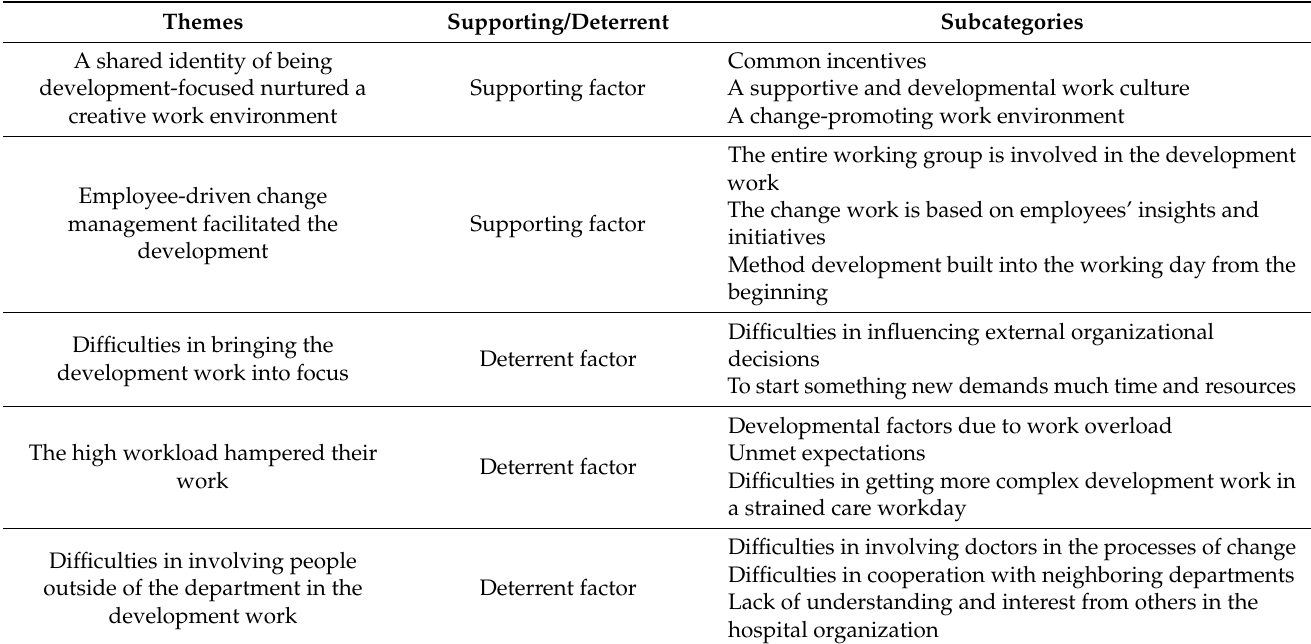
Table 2. Themes and subcategories of supportive and deterrent factors experienced by employees in the department in the work for an improved work